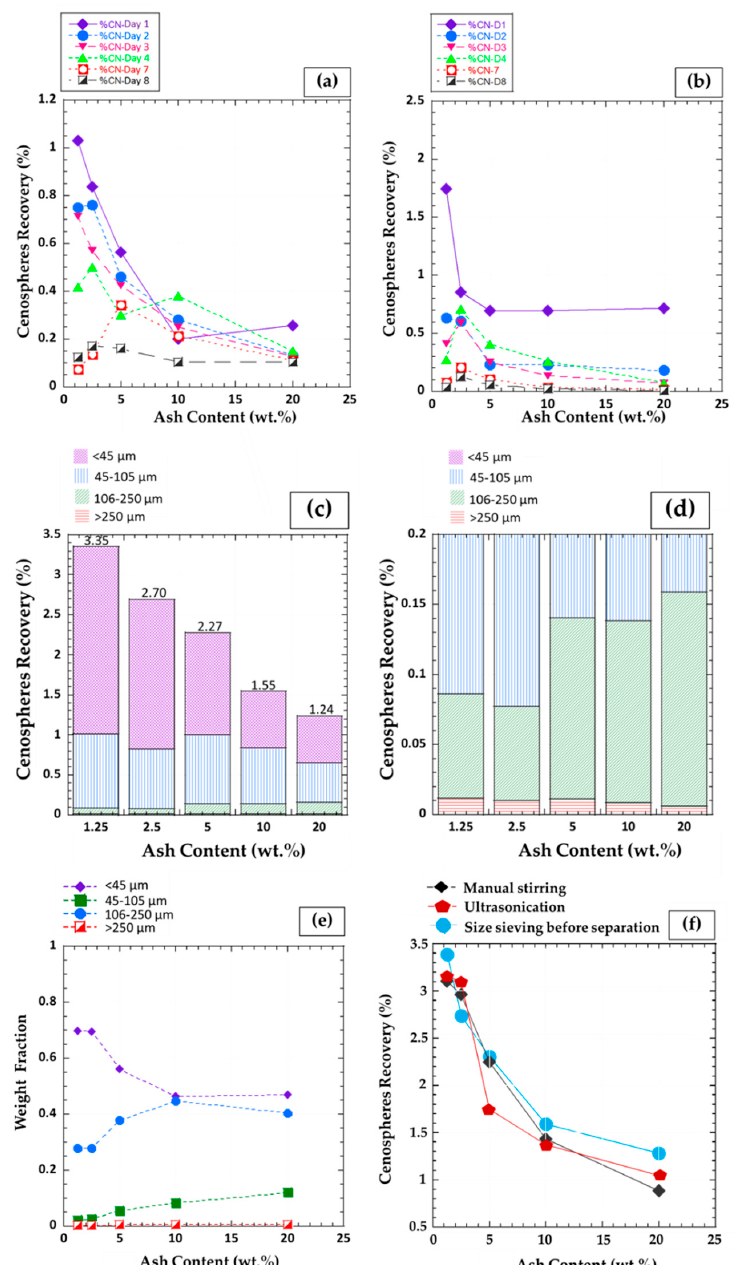
Figure 1. Plots of percentage recovery of cenospheres collected by sink-float method, using different ash contents, an eight-day period. The mixtures were ( a ) manually stirred for 10 min; ( b ) ultrasonicated for 30 min. ( c , d ) The percent cenospheres recovery obtained from using the starting fly ash being sieved into four sized fractions (<45, 45–105, 106–250, >250 µm) prior to the cenospheres separation; ( d ) is the zoomed-in plot for the conditions of 106–250 and >250 µm. ( e ) Plots of weight fraction of the data shown in ( c , d ) against ash content. (f) Overlay plots of accumulative percent cenospheres recovery against ash content for the data shown in ( a – d ).